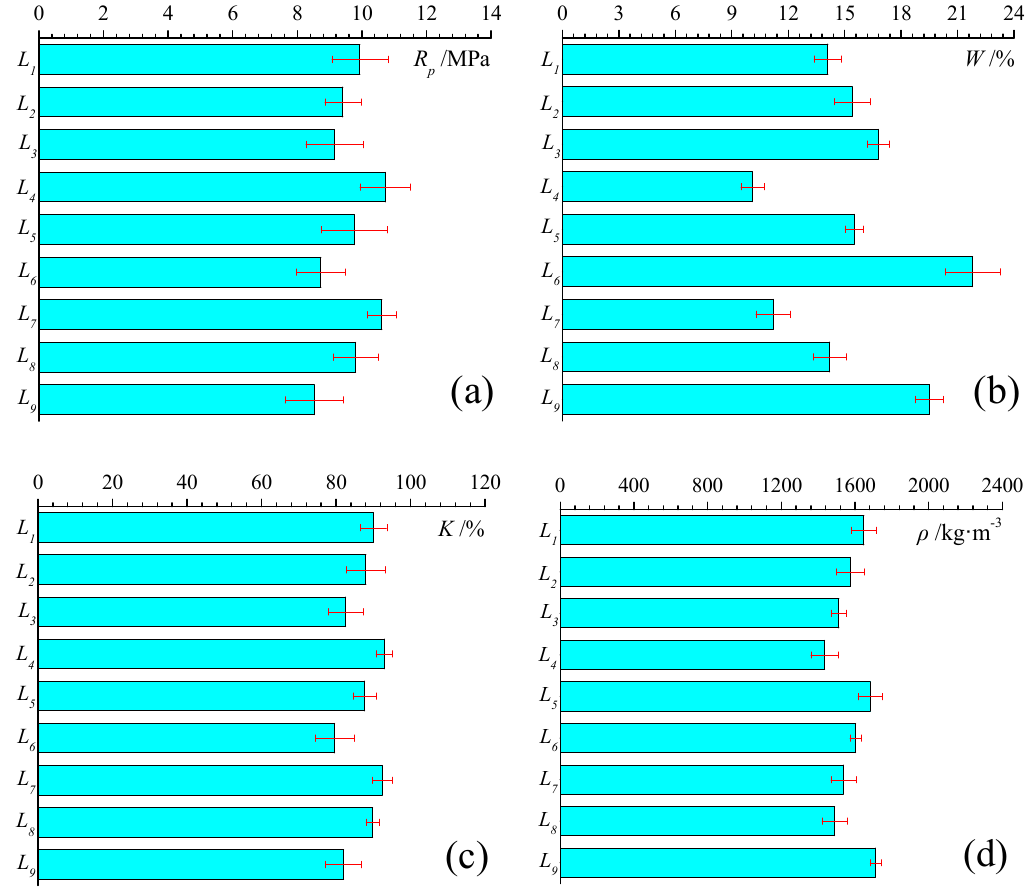
Figure 5. Orthogonal test results of compressive strength ( a ), water absorption rate ( b ), softening coefficient ( c ) and bulk density ( d